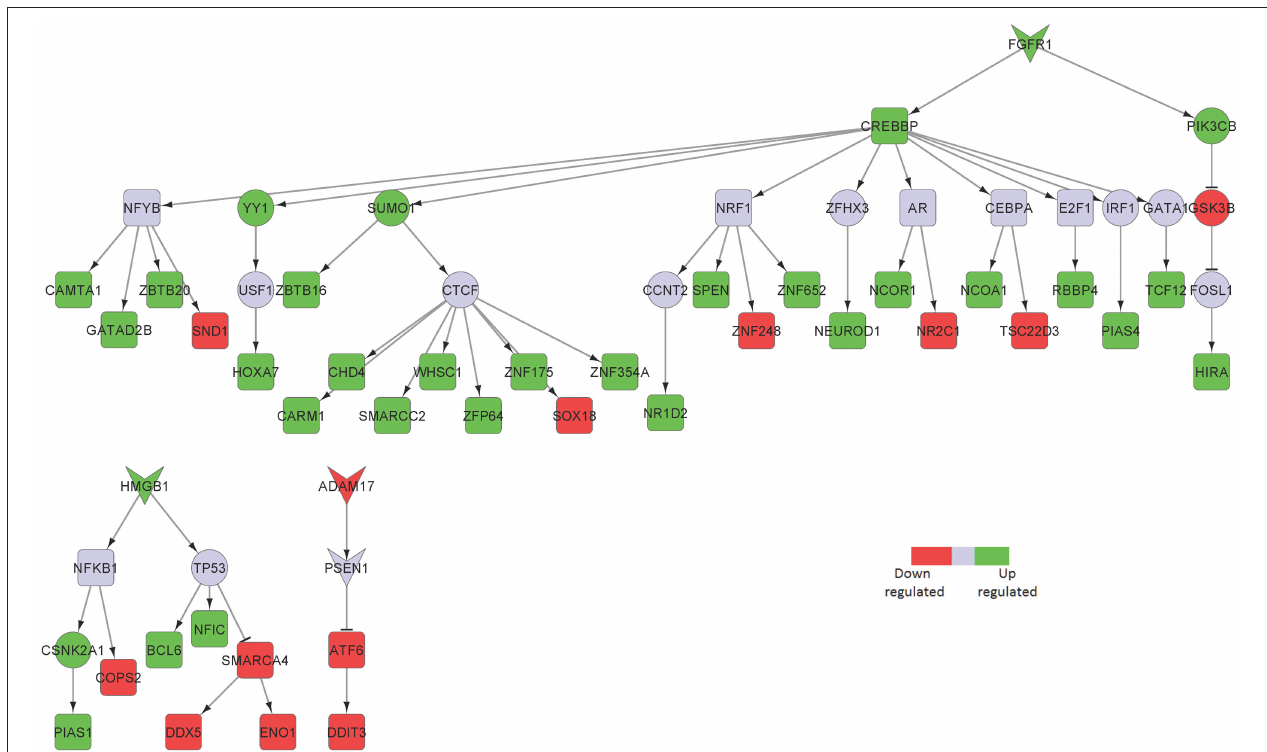
FIGURE 2 | Key signaling networks identified for the hippocampus. The figure shows three key signaling subnetworks controlled by FGFR1, HMGB1, and ADAM17 identified for hippocampus with known role in AD. FGFR1 mediated subnetwork was found to control of 23 up- and 6 downregulated TFs, HMGB1 mediated pathways controlled 3 upregulated and 4 downregulated TFs, and ADAM17 controlled 2 downregulated TFs. Further, FGFR1 and HMGB1 represent constantly activated signaling subnetworks while ADAM17 represent constantly inhibited signaling pathways. Inverted triangles denote receptor/ligand molecules, circular nodes represent signaling intermediates, and square nodes represent transcription factors. Any node that is not a TF or a receptor/ligand is considered a signaling intermediate such as kinases/phosphatases and adapter molecules. The edges with arrowhead denote activation and those with dashed head denote inhibitory interactions. Green nodes indicate upregulated genes in hippocampus region of AD brain, while the red nodes indicate downregulated ones. Blue nodes represent those intermediates that are not differentially expressed but serve to link the differentially expressed receptor/ligand to the downstream TFs. Supplementary Figure 1 contains the other subnetworks identified for hippocampus that did not have known role in